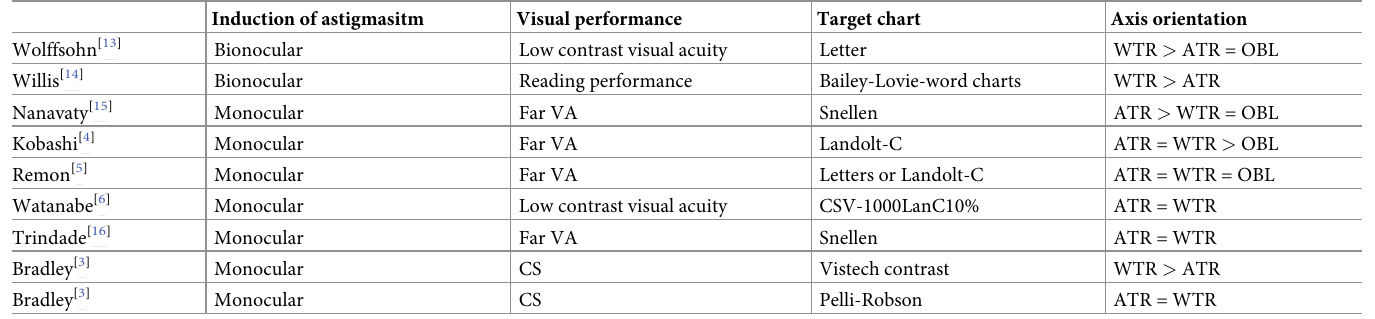
Table 2. Summary of previous studies comparing the effect of axis on visual